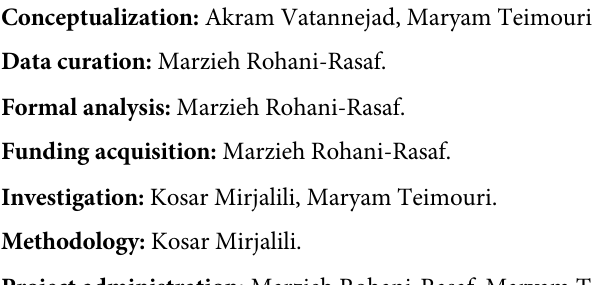
S1 Fig. Flow chart for patients’